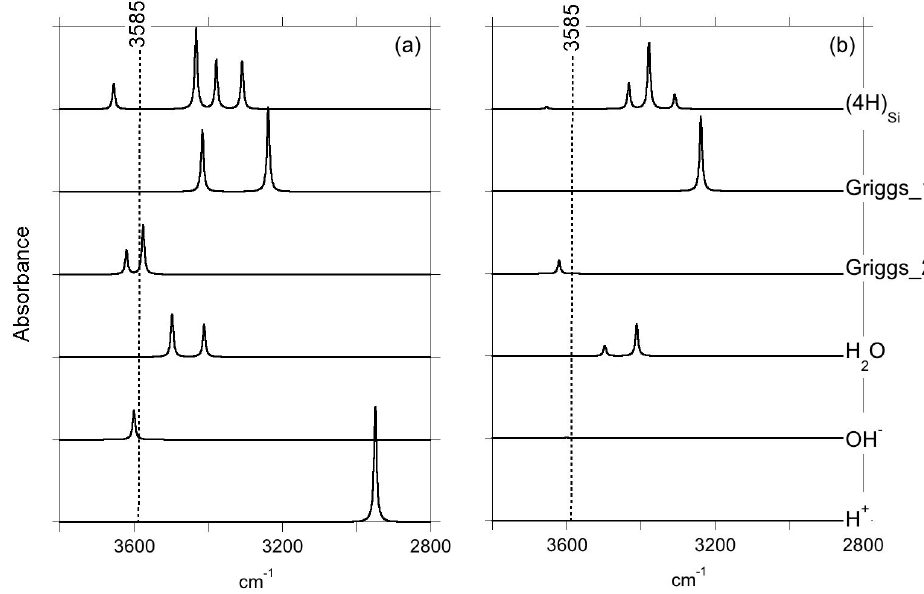
Figure 2. Theoretical IR absorption spectra of selected OH-bearing defects in the quartz–water system for polarizations perpendicular (a) and parallel (b) to the [001] direction. The position of the main IR band experimentally observed in the quartz–water system (Fig. 1) is indicated by the dotted